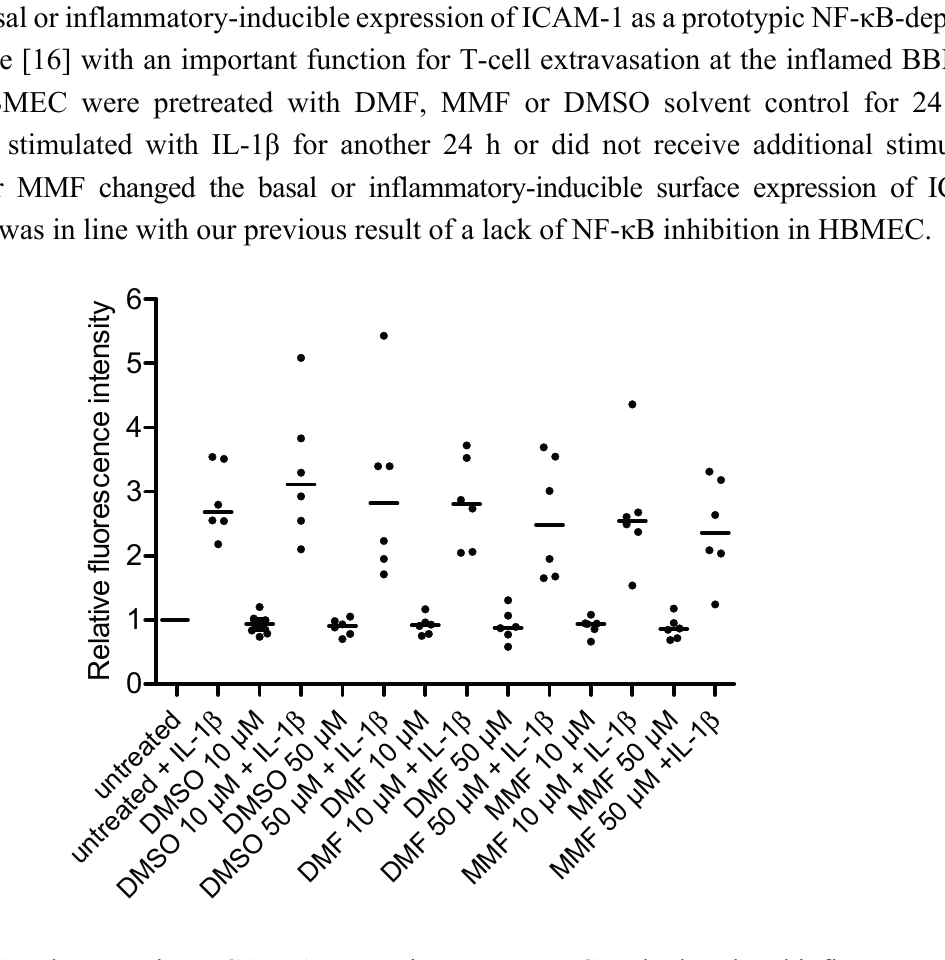
Figure 2. FAE do not reduce ICAM-1 expression on HBMEC under basal and inflammatory conditions. Subconfluent HBMEC were left untreated or exposed to DMF or MMF at concentrations of 10 or 50 µM, or to DMSO as a solvent control, at